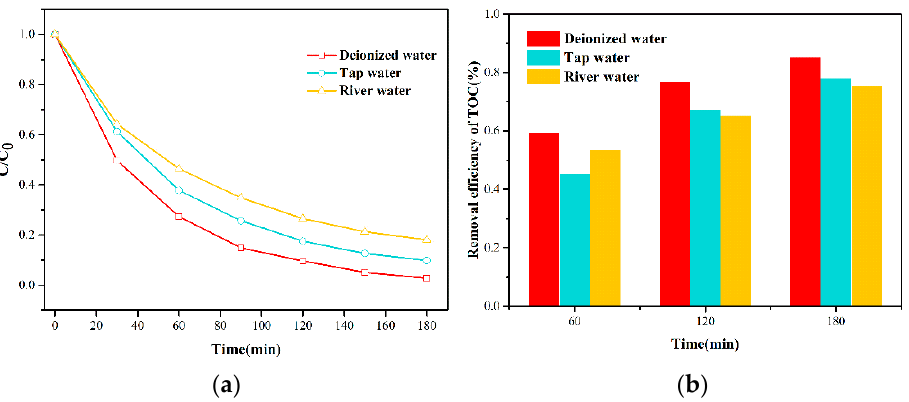
Figure 7. ( a ) Effect of MOF-525-Fe/Zr@CF degradation of SMX in different wastewater in PEF system; ( b ) TOC degradation efficiency diagram. Table 3. Comparison of SMX degradation efficiency of related catalysts